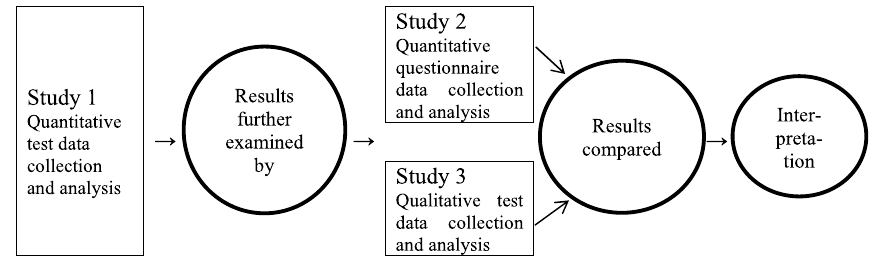
Fig. 1 Overall study design based on Creswell and Plano Clark (2018)